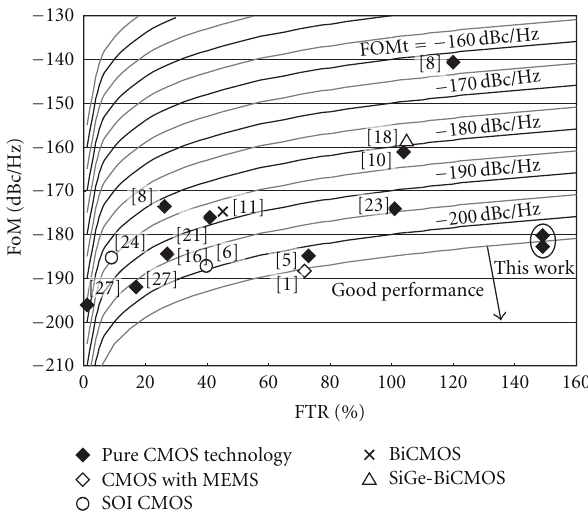
Figure 11: VCO performance comparison using FoM and fre-